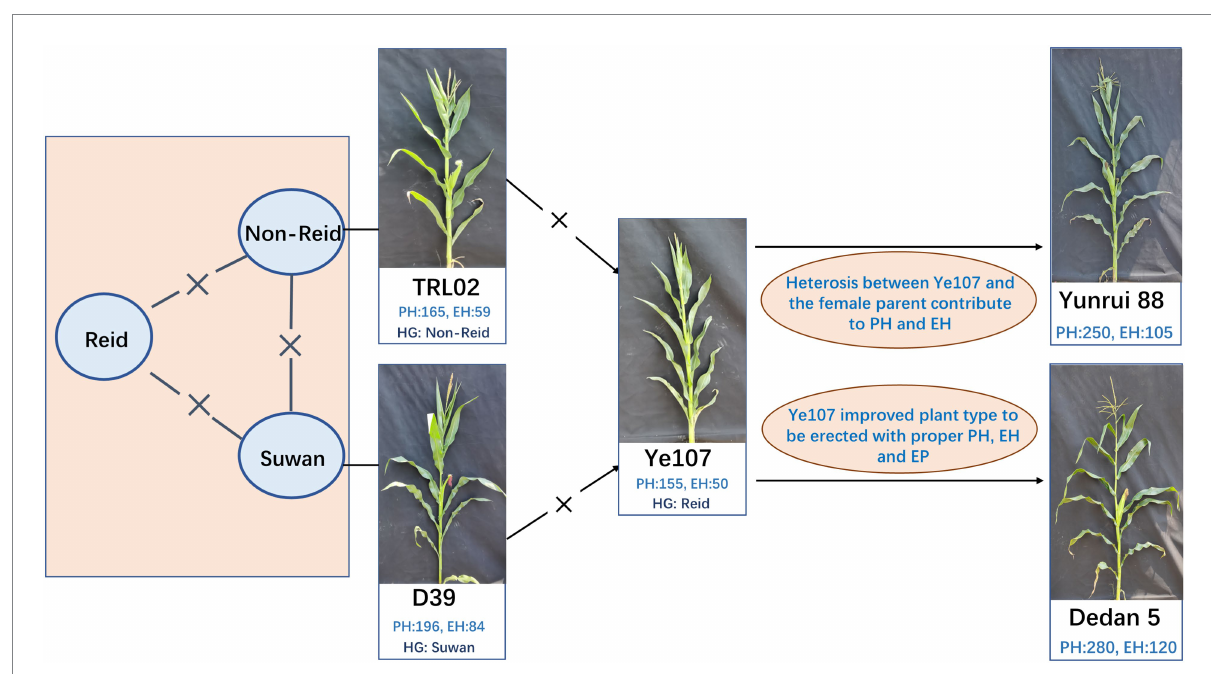
FIGURE 1 Breeding strategy of the two hybrids by applying triangle heterotic pattern using TRL02, D39, and Ye107 (Fan et al., 2014).